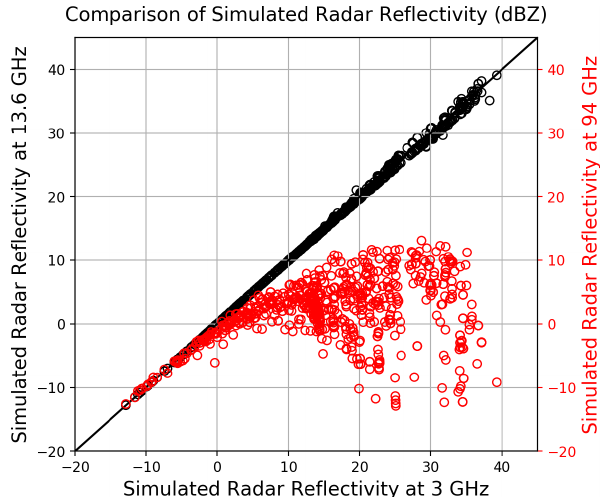
Figure 1. Scatterplots of radar reflectivity values simulated by the COSP simulator at 3GHz ( x axis) vs. those simulated at 13.6GHz (left y axis) and 94GHz (right y